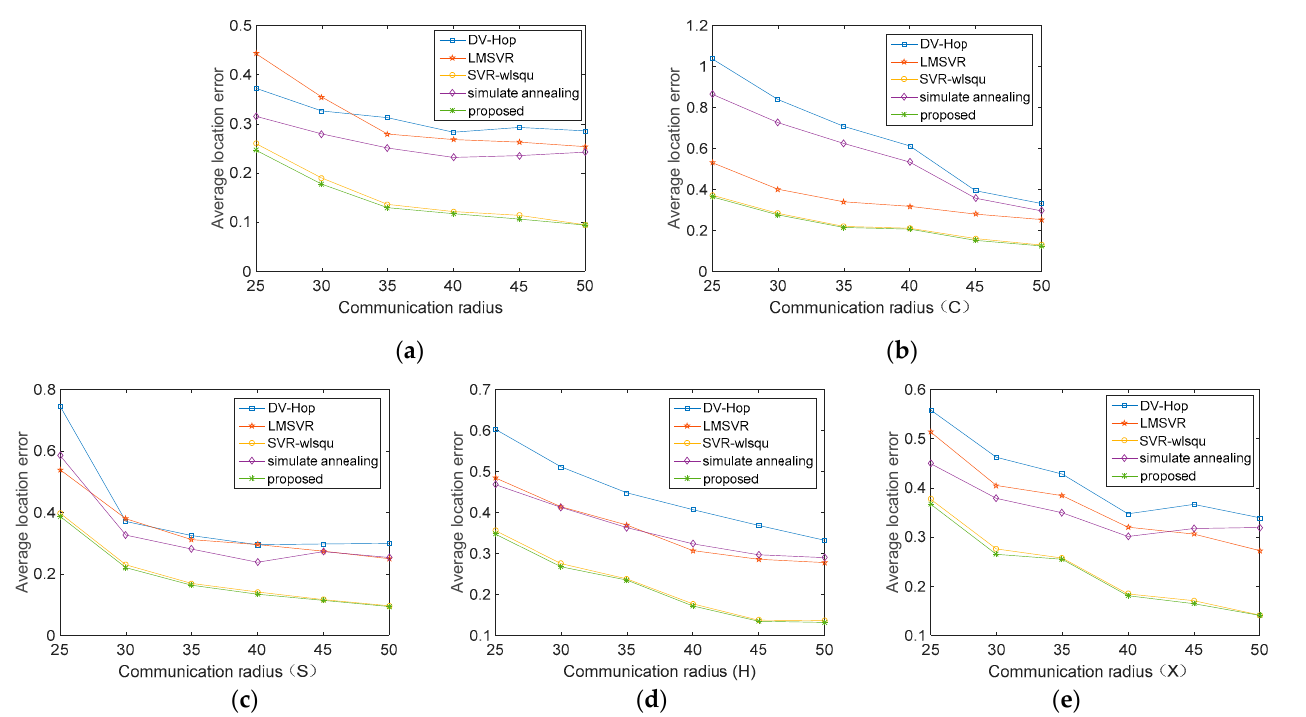
Figure 3. Comparison of the average location error under various communication radius distances. ( a ) isotropic networks. ( b ) C-shape network. ( c ) S-shape network. ( d ) H-shape network. ( e ) X-shape network.